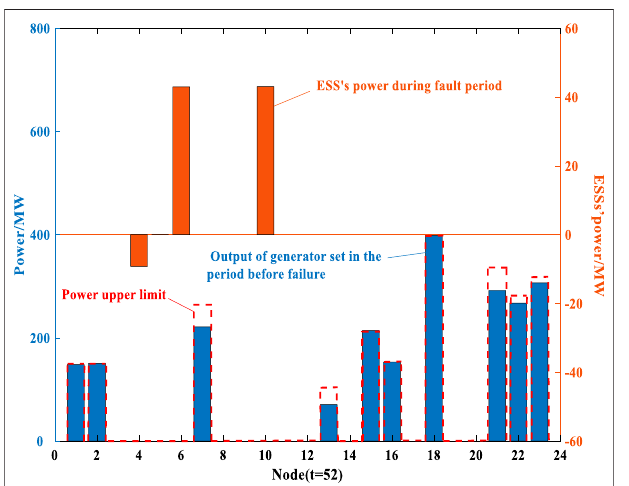
FIGURE 15 | Power outputs (MW) of generating units before UHV transmission failures and discharge (+ve) and charge ( − ve) rates (MW) of ESS during fault occurrences.